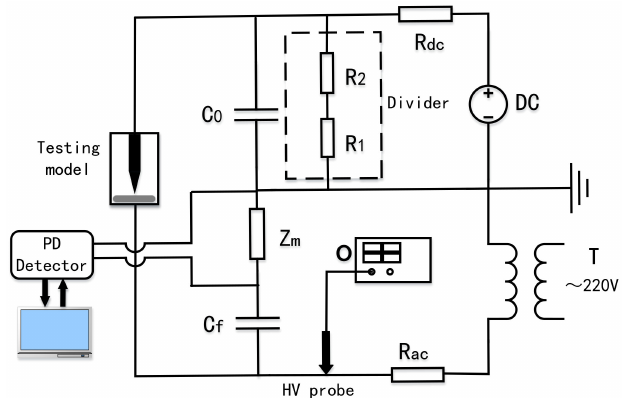
Figure 2. Partial discharge measurement